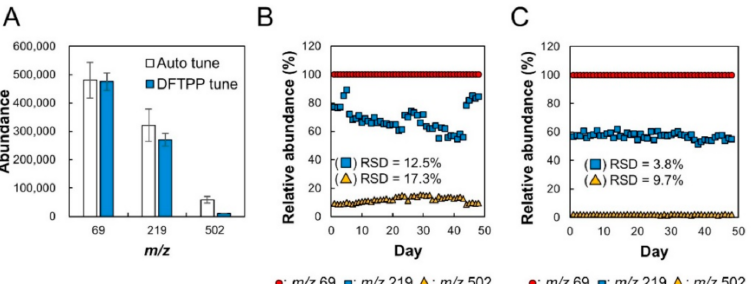
Figure 2. Differences in target ion count due to the MS tuning condition between auto tuning and decafluorotriphenylphosphine (DFTPP) tuning. ( A ) Average absolute abundance (ion count per second) over 48 days at m / z = 69, 219, and 502. Open bars indicate the results obtained using the auto tuning method, and black bars indicate that obtained using the DFTPP tuning method. Error bars represent the standard deviation ( n = 3). ( B , C ) Tuning logs of the auto tuning and DFTPP tuning, respectively, represented by the time course of relative